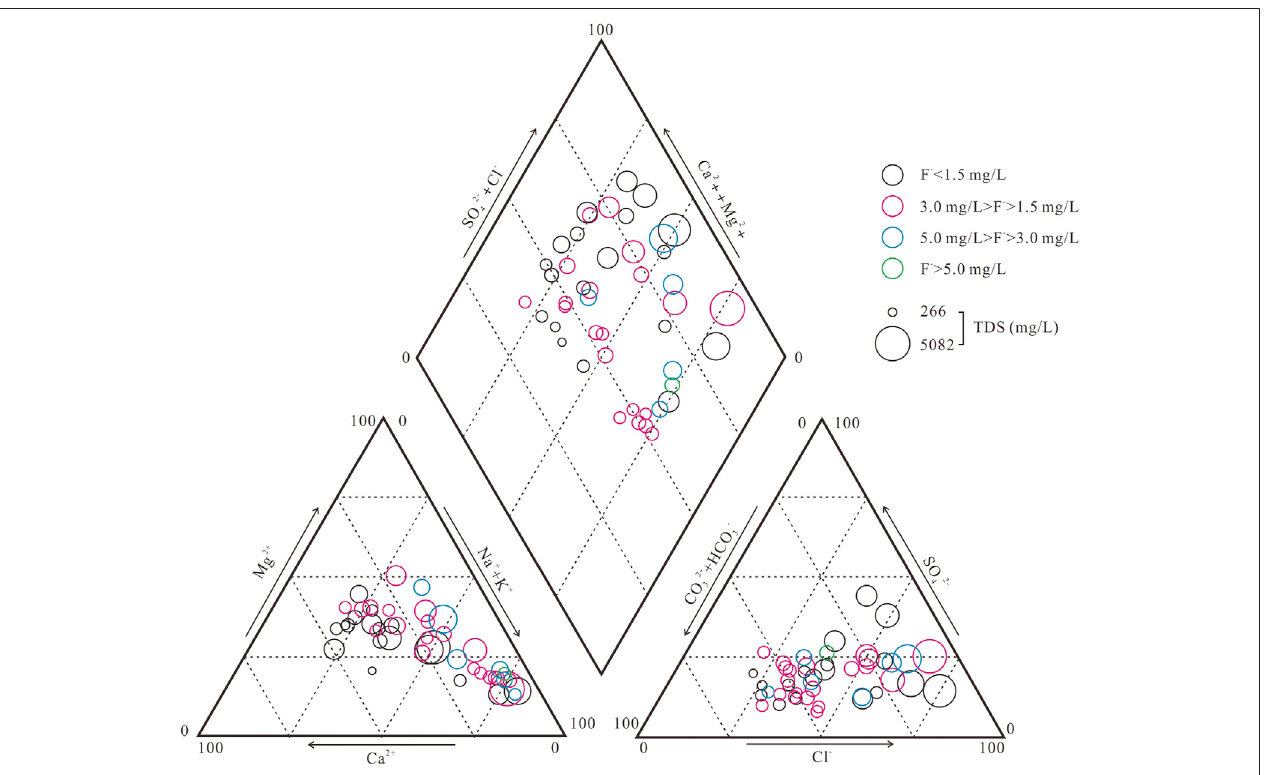
FIGURE 2 | The spatial distribution of main ions in study area (Ca 2+ , Na + , Cl - , HCO 3 − , NO 3 -N and TDS).